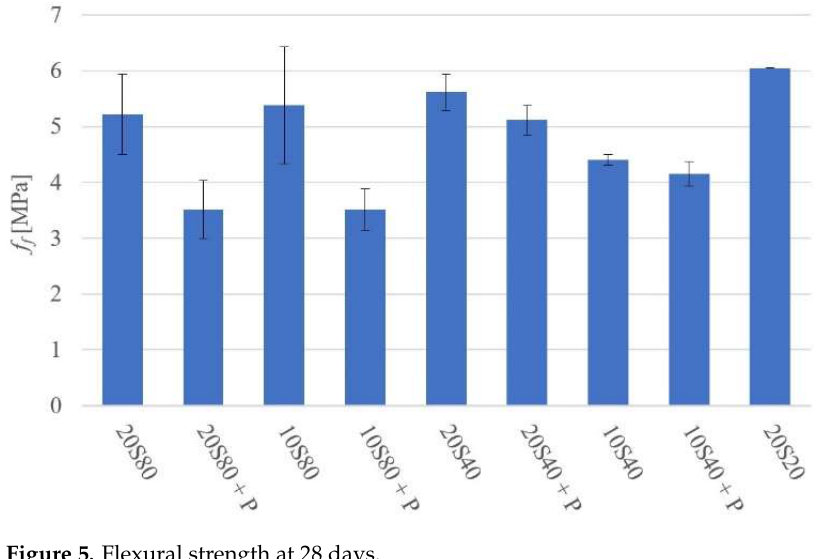
Figure 5. Flexural strength at 28 days.